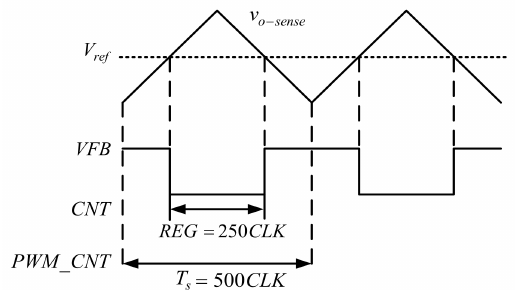
Figure 9. Average value of v o-sense equal to the value of V ref .